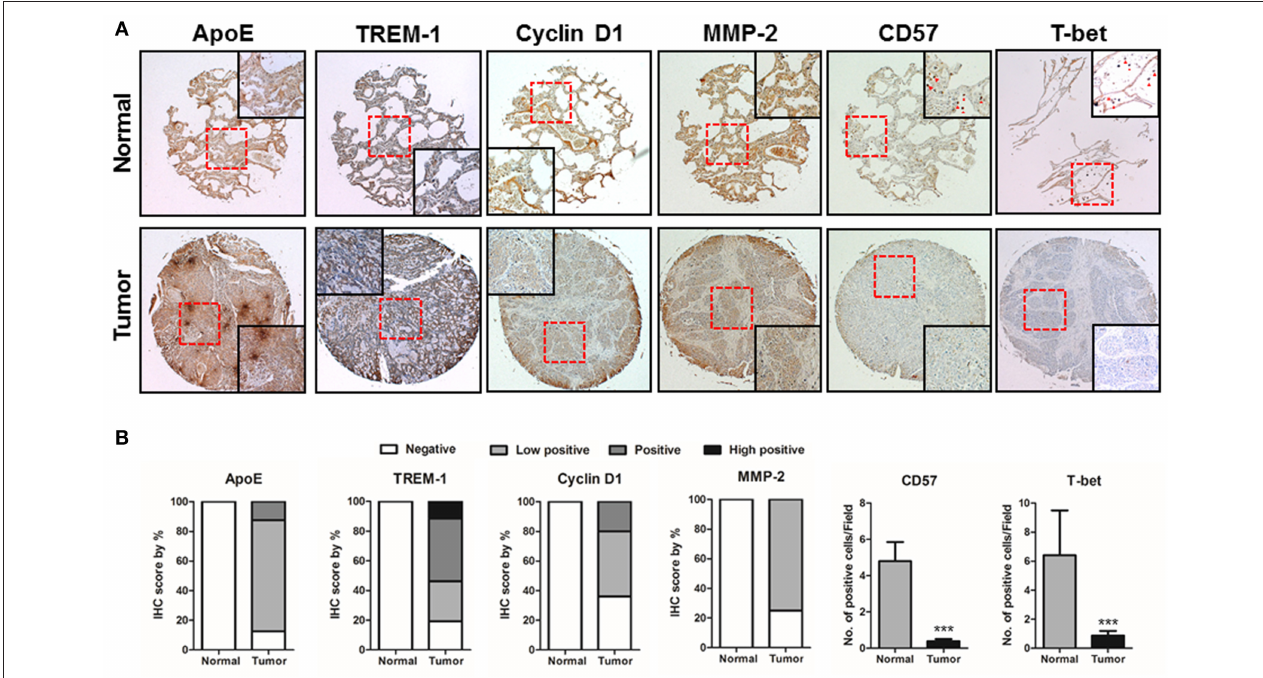
FIGURE 7 | ApoE, TREM-1, Cyclin D1, MMP-2, CD57, and T-bet expressions in the progression of lung tumors. (A) Tissue microarray analysis showing the expression of ApoE, TREM-1, Cyclin D1, MMP-2, CD57, and T-bet during lung tumor progression in normal and tumor tissue samples. Representative immunohistochemical images of each groups. (B) Bar graphs showing the ratio of ApoE, TREM-1, Cyclin D1, MMP-2, CD57, and T-bet expressions. Tissue microarray samples are contained of 10 samples from normal lung tissues and 140 samples from lung tumor tissues. *** p <